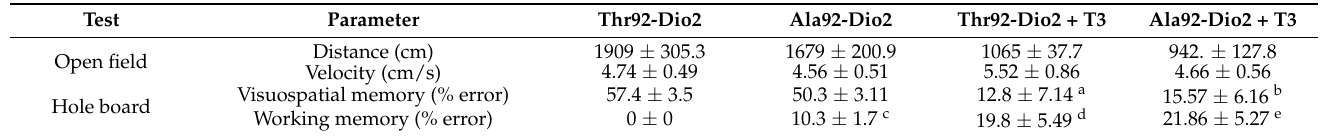
Table 4. Cognitive and behavioral phenotype of 3–4-old-month female Ala92-Dio2 mice treated with